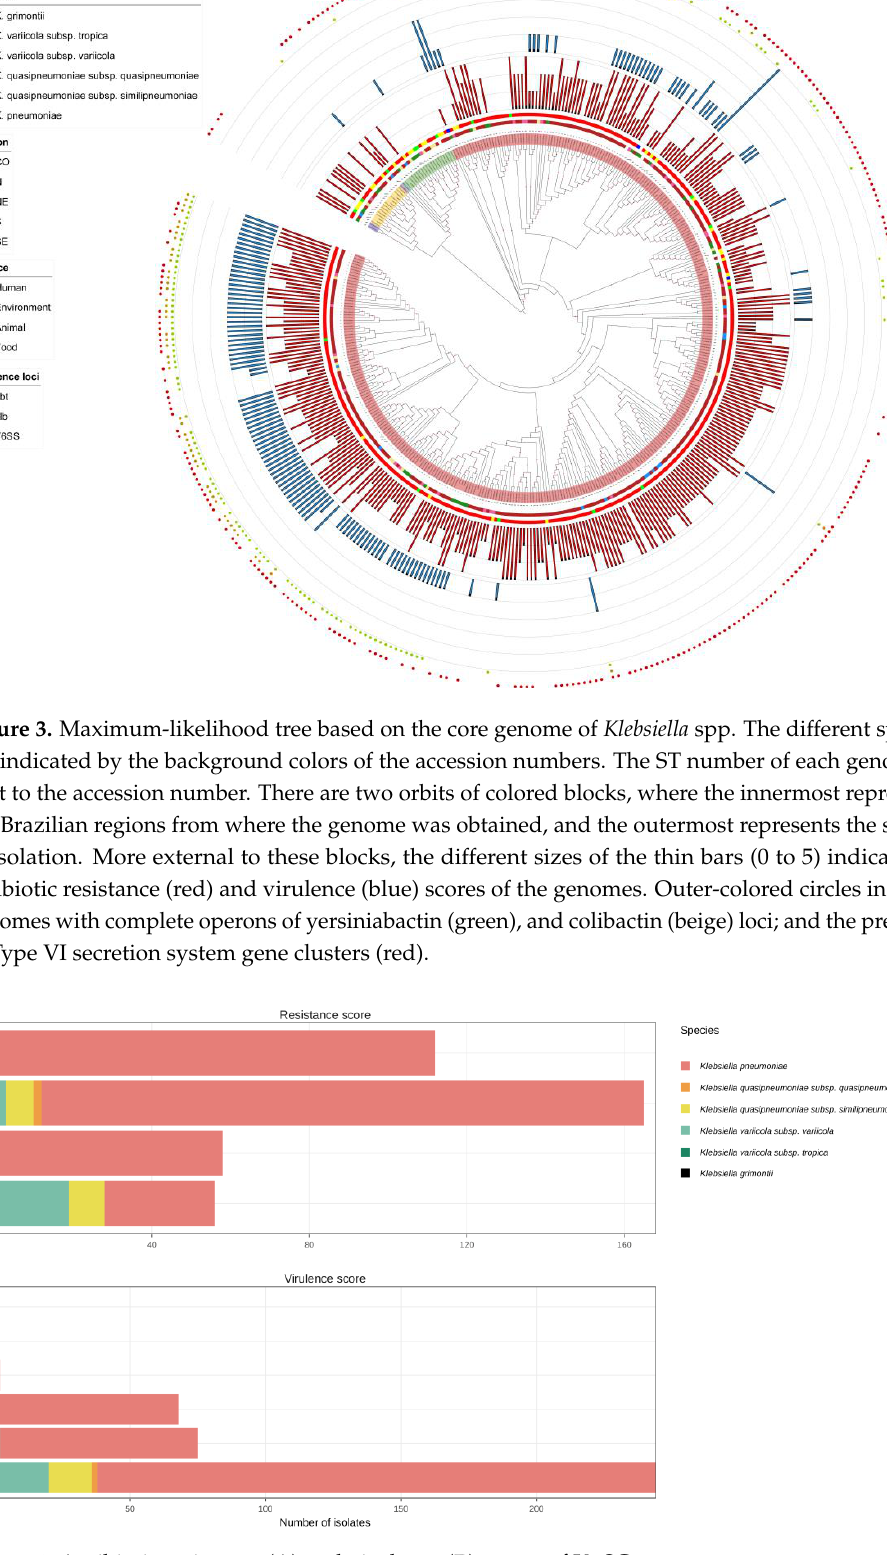
Figure 4. Antibiotic resistance ( A ) and virulence ( B ) scores of